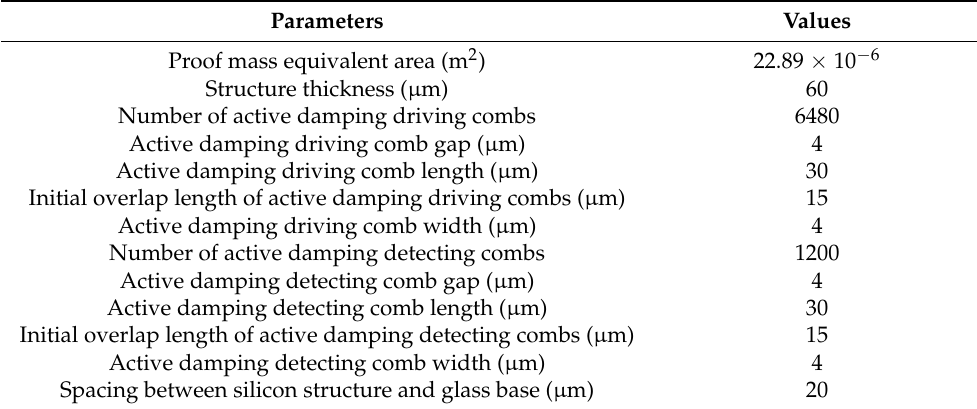
Table 1. Structural dimensions associated with the electrostatic active damping control.